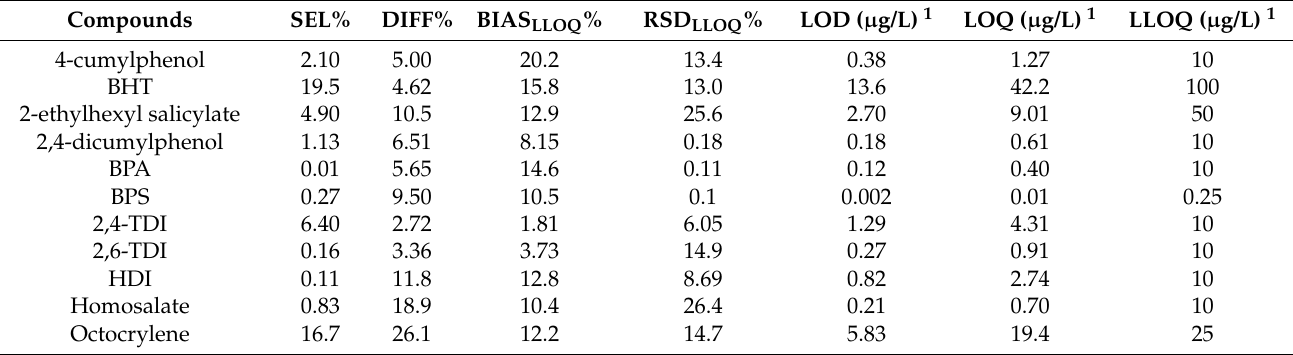
Table 4. Parameters for NIAS analytical standards evaluated with the developed online SPE-UHPLC- tandem MS